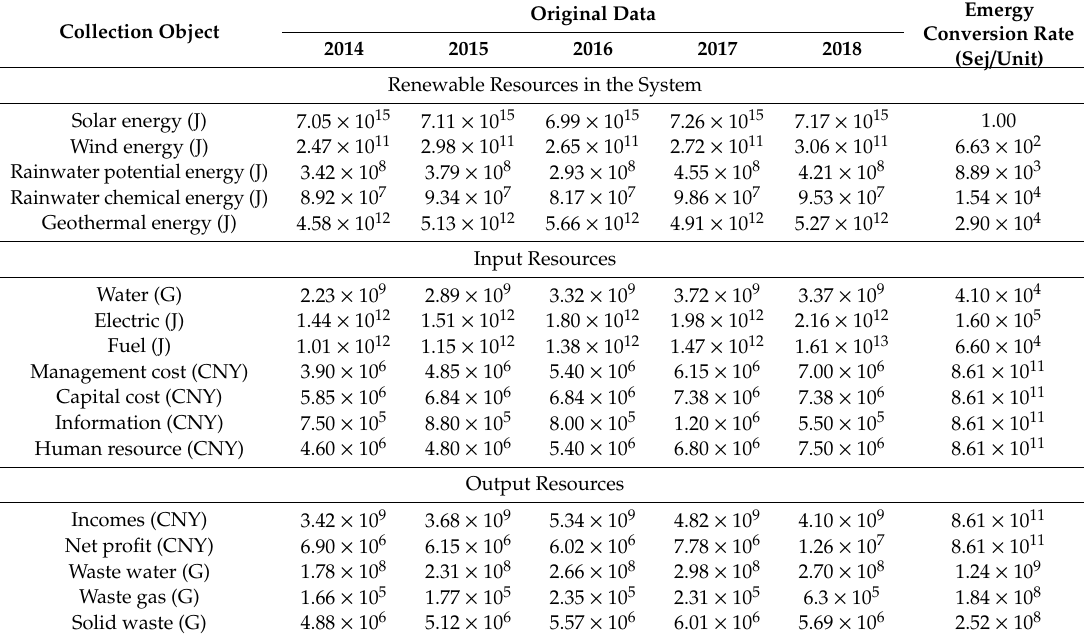
Table 2. The energy data of the logistics park in